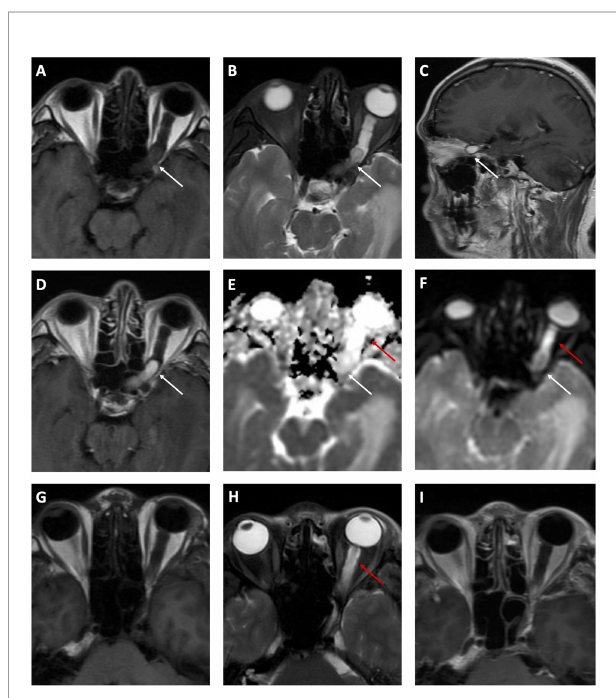
FIGURE 1 | Preoperative (A – F) and postoperative (G – I) MRI. A hypointense mass (white arrows) from the left orbit apex to the anterior cranial fossa is shown on T1-weighted axial (A) MRI scan. It is hyperintense on T2-weighted axial (B) and sagittal (C) MRI scans, with a signi fi cant enhancement on contrast images (D) . Obvious hyperintensity is identi fi ed on the ADC map (E) but not on DWI (F) . The mass is absent on both T1WI (G) and T2WI (H) while edema (red arrows) recedes incompletely. The contrast scan (I) shows no enhancement indicating the mass was excised